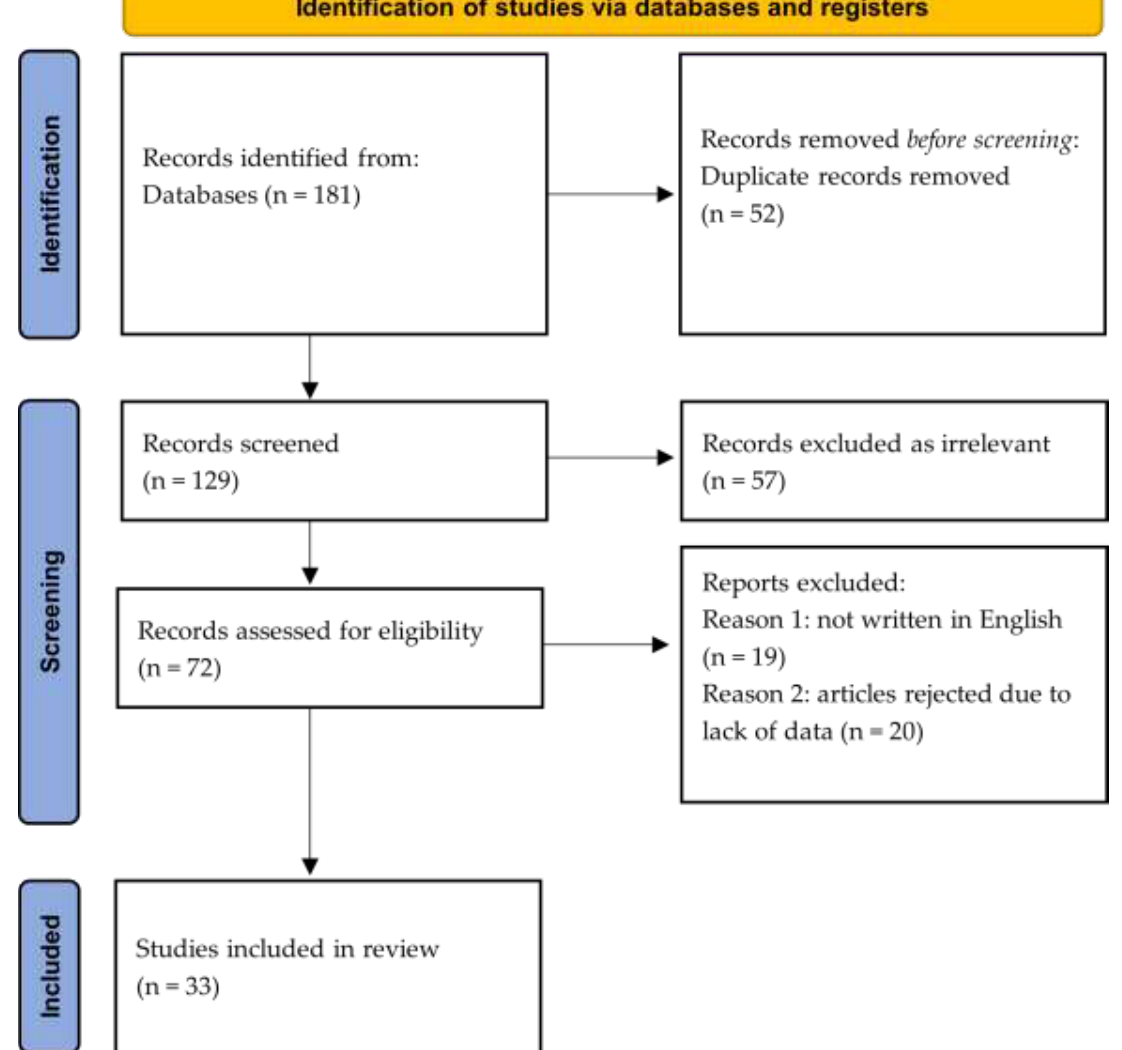
Figure 1. Flow diagram of literature search and article selection process according to the PRISMA guidelines [24].